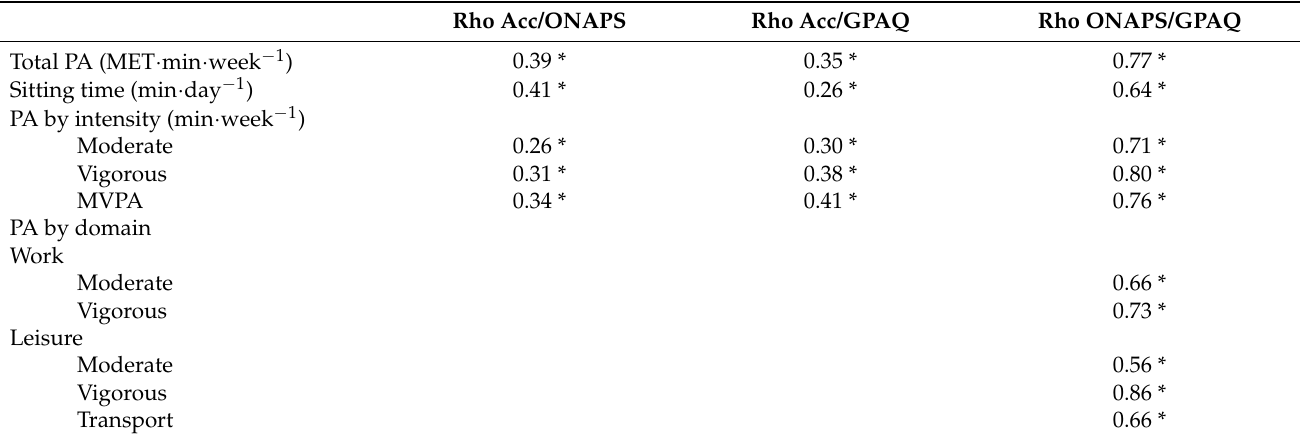
Table 3. Results of Spearman correlations between accelerometer (Acc) and ONAPS-PAQ (Spearman’s rho Acc, criterion validity) measure, between accelerometer and GPAQ measure, and between ONAPS-PAQ and GPAQ measure (Spearman’s rho GPAQ, concurrent